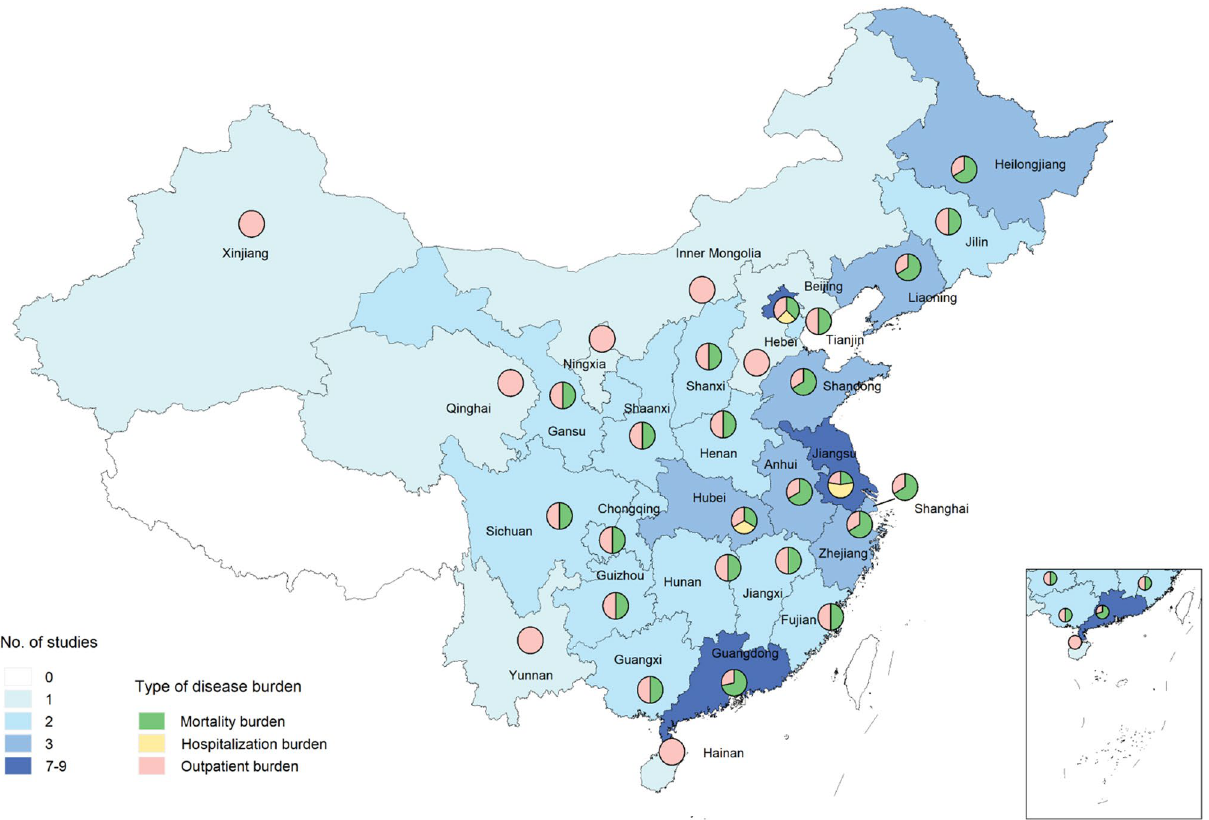
Figure 2. The distribution of published studies about influenza-associated disease burden. Two studies of mortality burden were not shown in the figure because they reported combined estimates of multiple cities 5 or Disease Surveillance Points (DSP) sites 9 . One study could have estimated influenza disease burden for multiple provinces or cities. The map was drawn using R software, version 3.5.2 (https ://www.r-proje